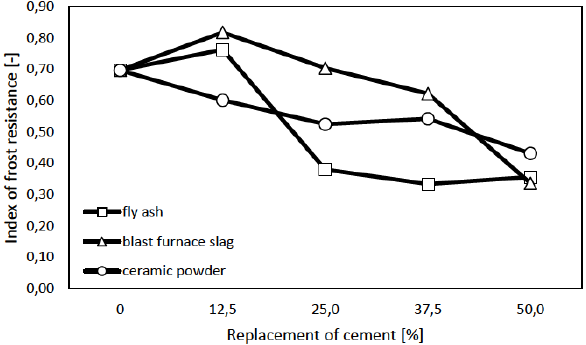
Figure 3: Index of frost resistance after 90 days and 50 freeze-thaw